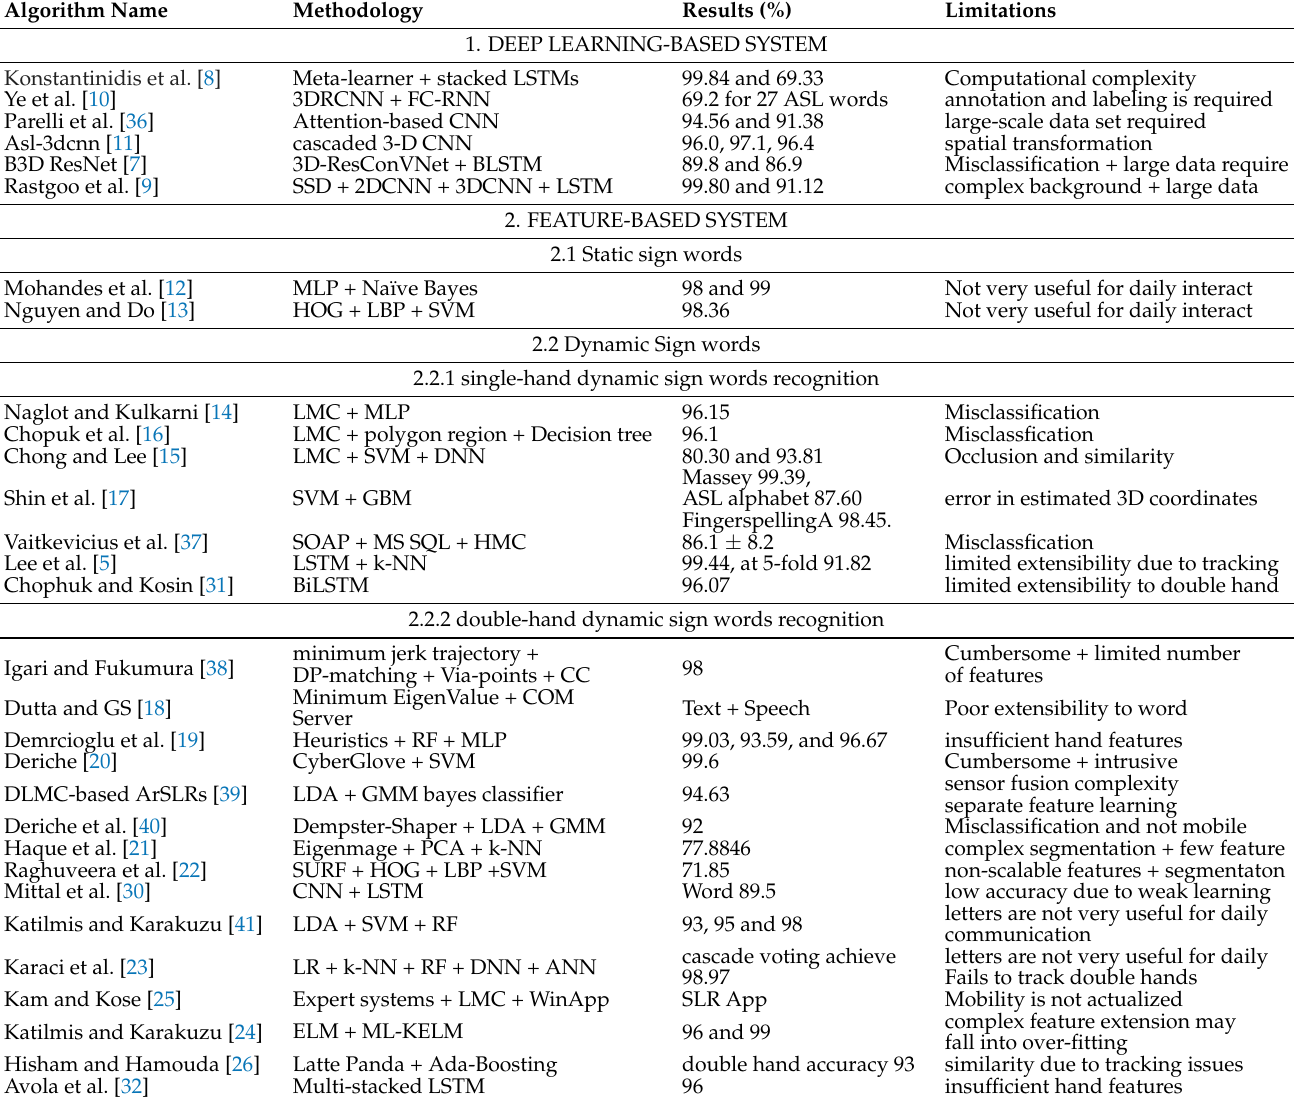
Table 1. Table of Related